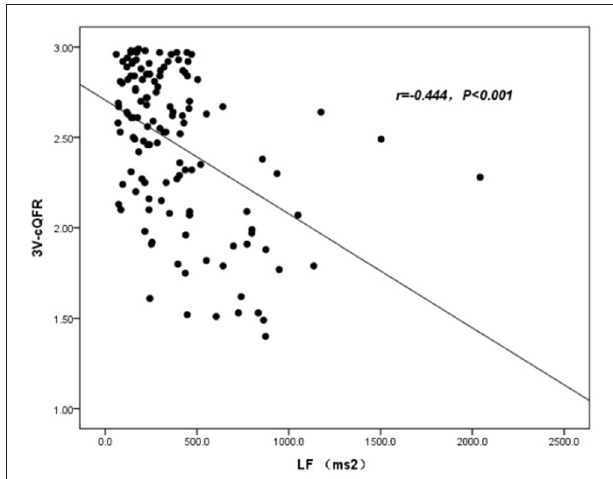
FIGURE 3 | Association analysis between 3V-cQFR and LF.